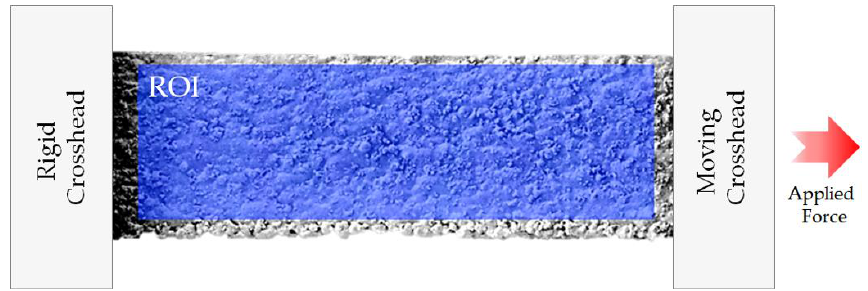
Figure 5. Appearance of surface of 3D-printed RS-333 alloy with the indicated (yellow arrows) surface features.